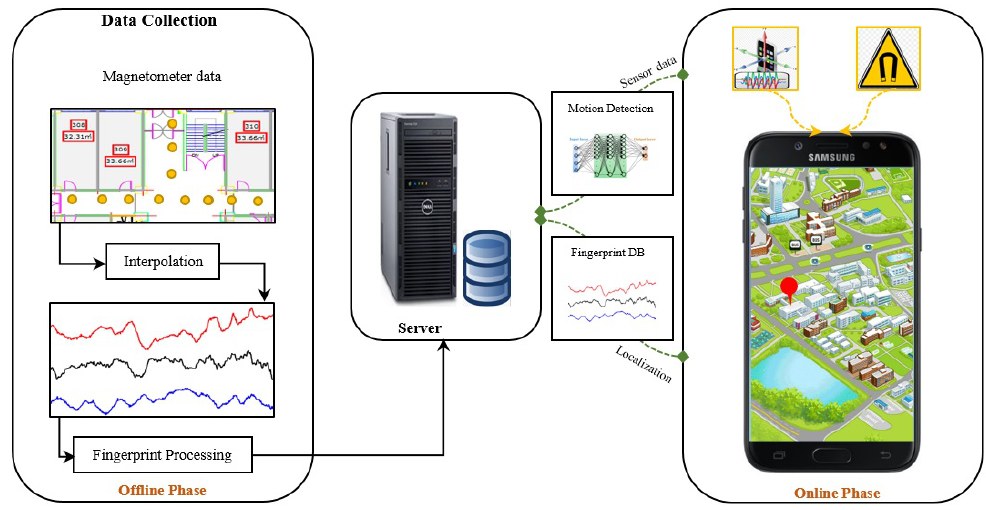
Figure 1. The diagram of the proposed localization